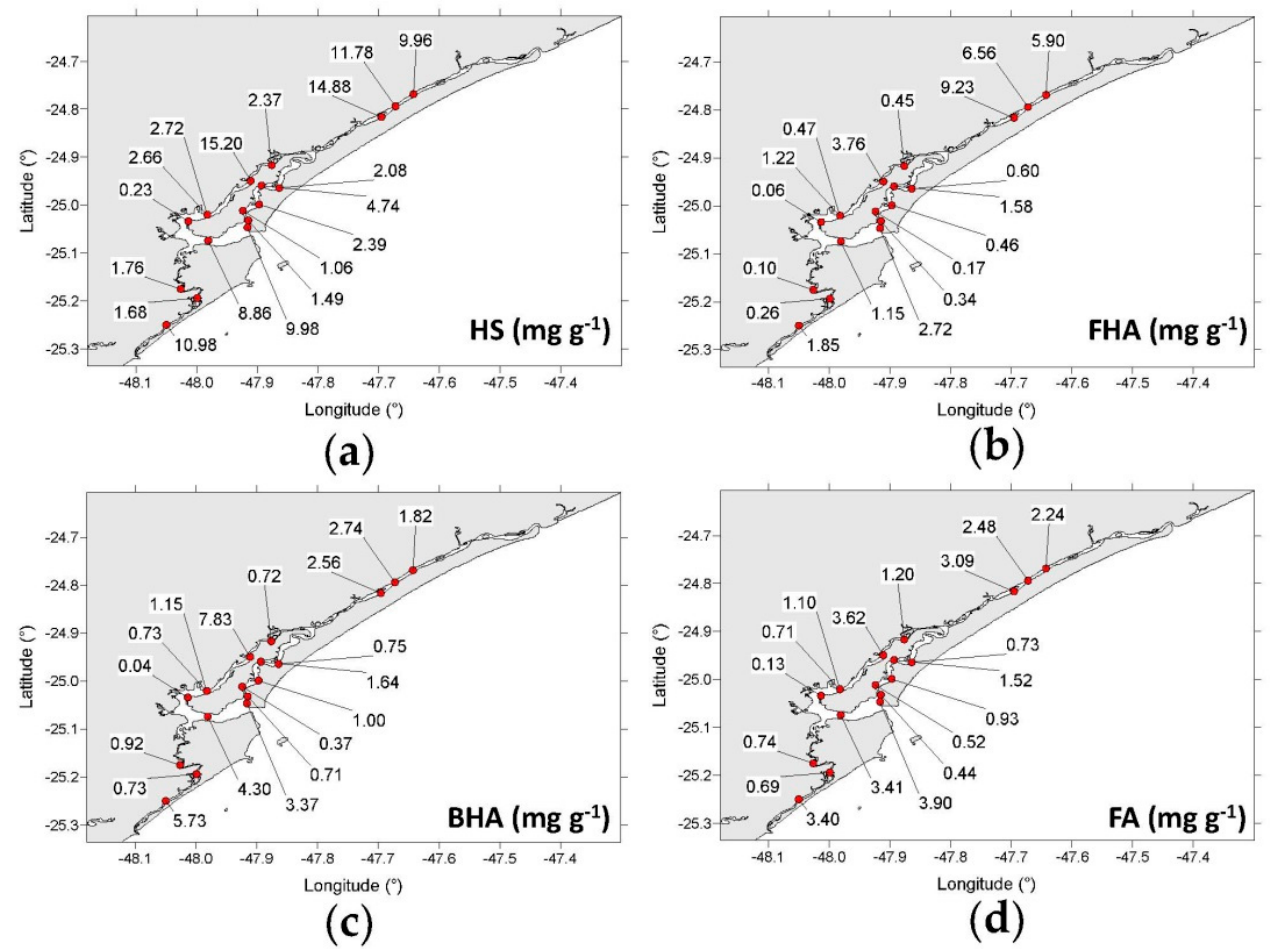
Figure 4. Spatial distribution of the concentrations (mg g − 1 ) of: ( a ) Humic Substances; ( b ) Free Humic Acids; ( c ) Bound Humic Acids; ( d ) Fulvic Acids.